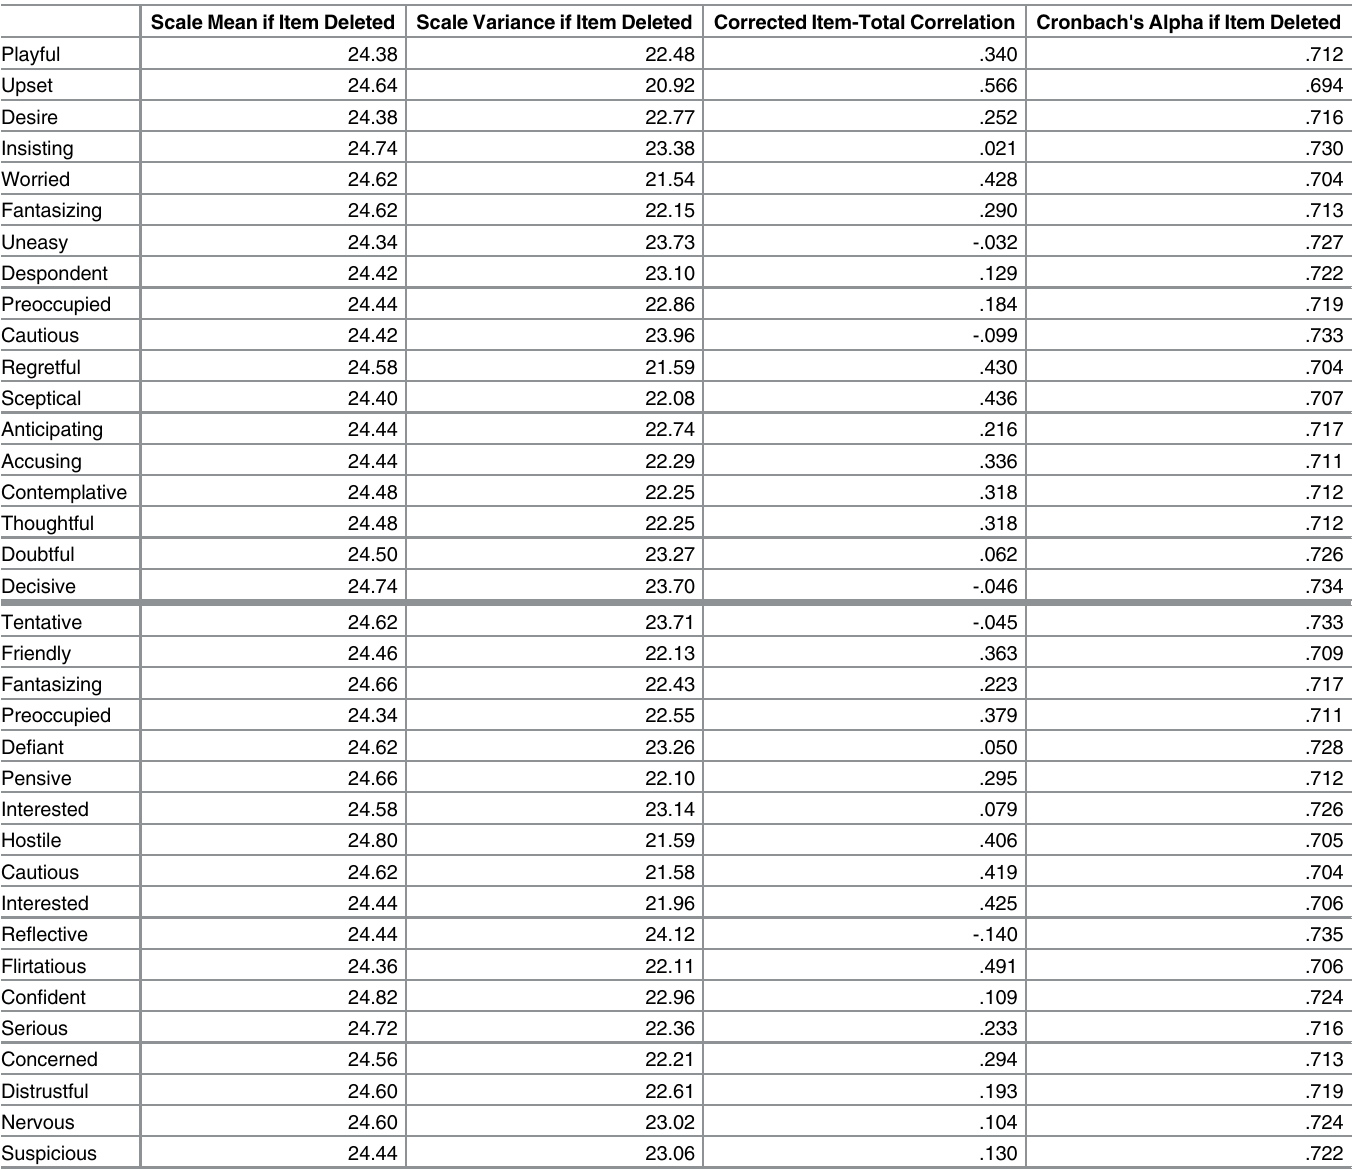
Table 1. Itemised Reliability